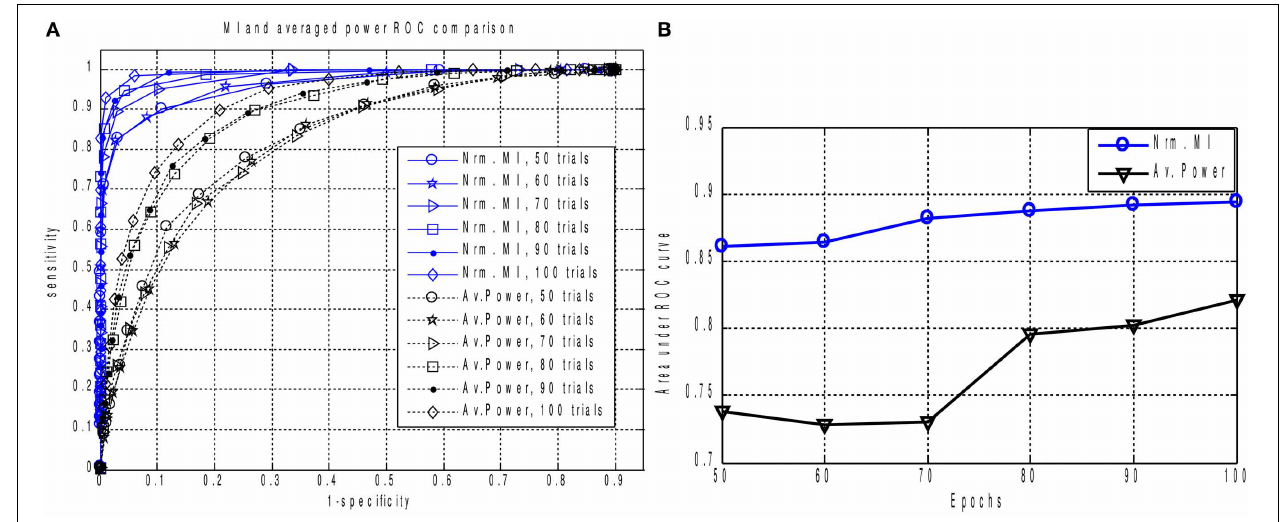
FIGURE 5 | (A) The family of ROC curves for Averaged Response Power and Mutual Information based detection for various number of epochs on the same plot. MI based detection clearly and significantly outperforms the conventional method. Even with 50 trials the MI based criterion (“Nrm. MI, 50 trials” curve) allows to achieve 70 percent of sensitivity with ideal specificity. We can see that for all counts of epochs the MI based